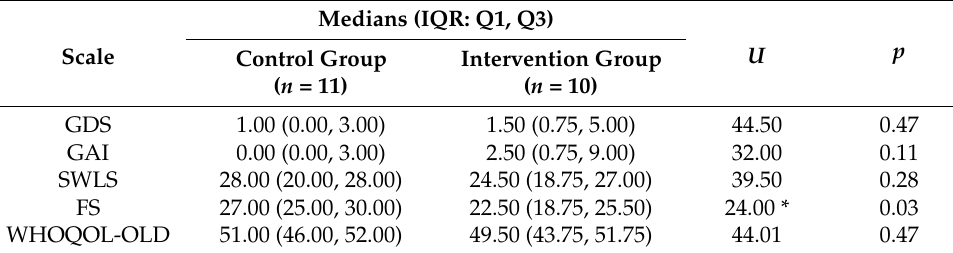
Table 2. Between-group differences in outcome scores at baseline.